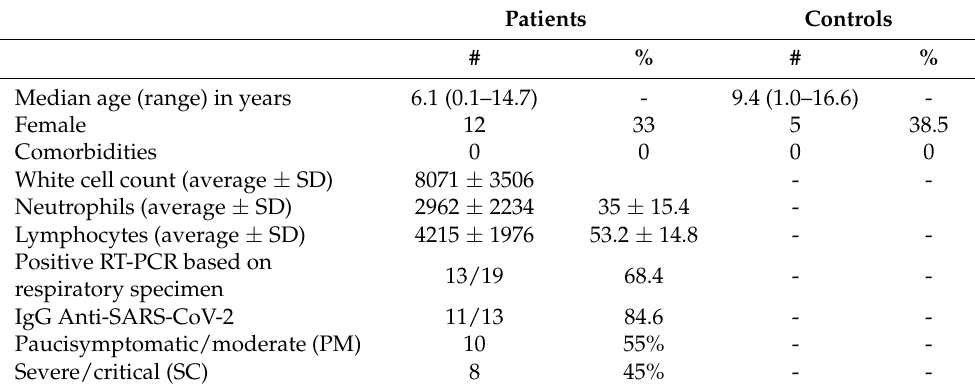
Table 1. Clinical characterization of pediatric patients and controls enrolled in the study.